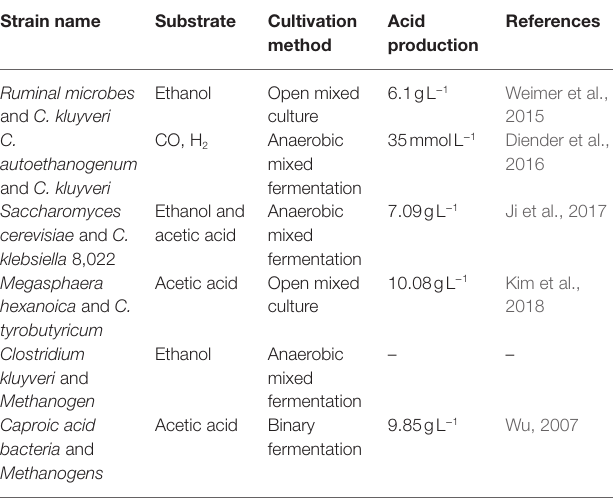
TABLE 3 | Co-culture and acid production of caproic acid-producing